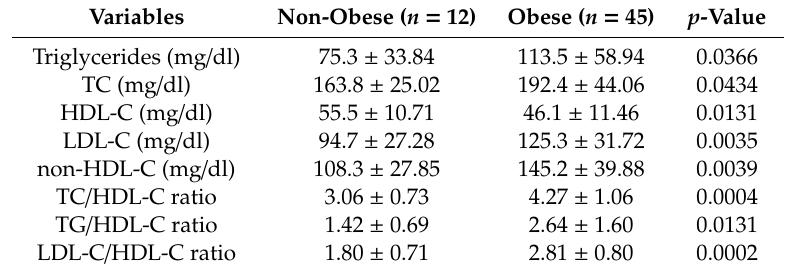
Table 7. Lipid profile based on the classification as obese or not according to waist circumference.